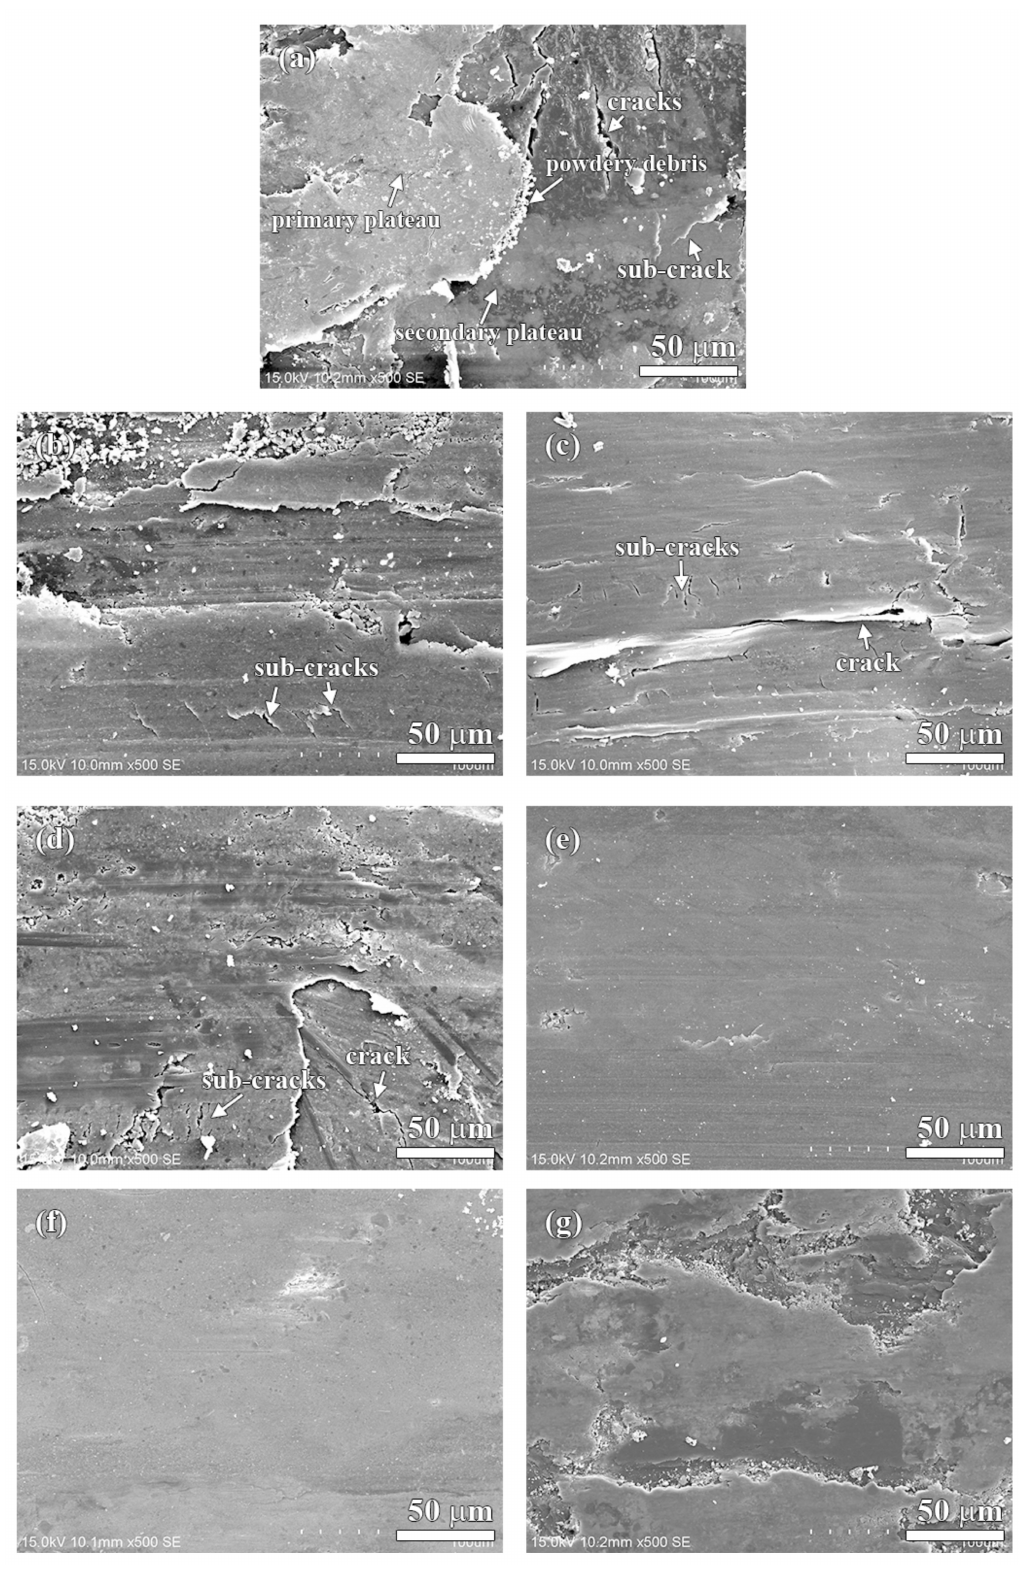
Figure 10. Detailed worn surfaces of specimens: ( a ) NAO, ( b ) Coke, ( c ) CB, ( d ) CF, ( e ) AG, ( f ) NG, ( g )